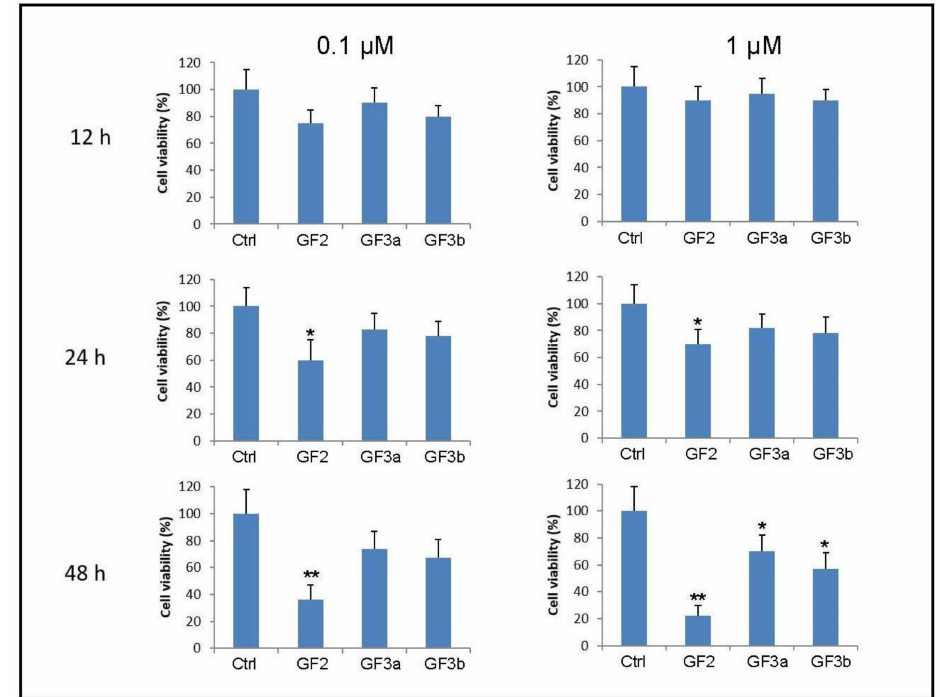
Figure 5. Evaluation of potential toxicity of GF2, GF3a, GF3b fibrous zeolites in Jurkat cell line. The histograms show cell viability after 12, 24, and 48 h of GF2, GF3a, and GF3b exposure at the concentration of 0.1 µ M and 1 µ M. Each value is expressed as a percentage ± SD (N = 3 independent experiments performed in triplicate; * p < 0.05, ** p < 0.01 vs.